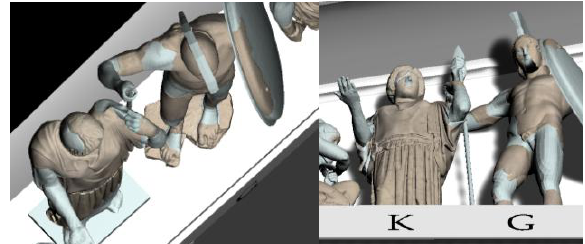
Figure 11. Figures K and G according to the open “A” arrangement